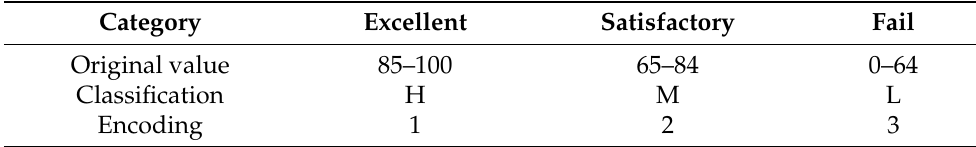
Table 2. The three-level classification system.